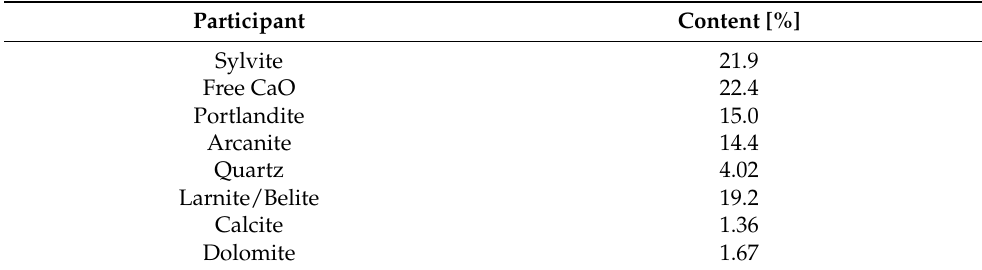
Table 2. Cement by-pass dust composition (in wt. %) measured by XRD.